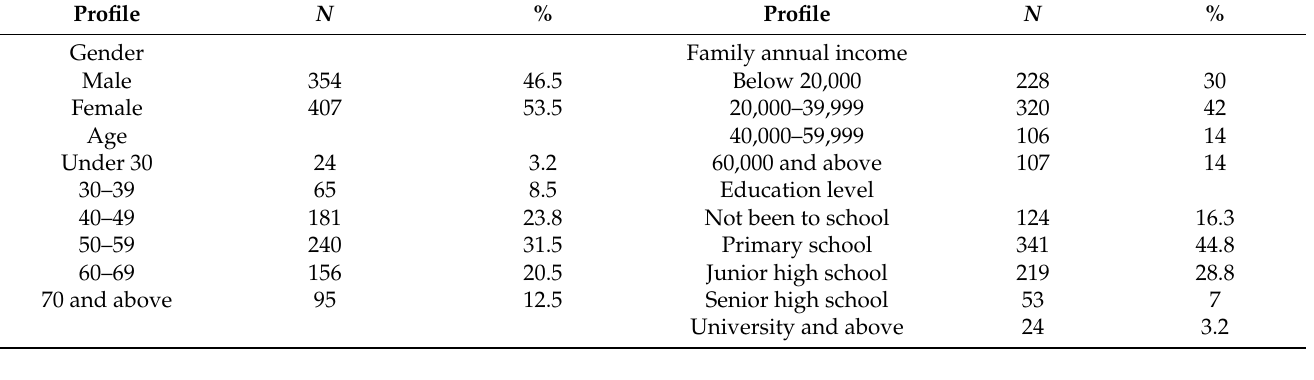
Table 3. Distribution of the socio-demographic characteristics of the samples.